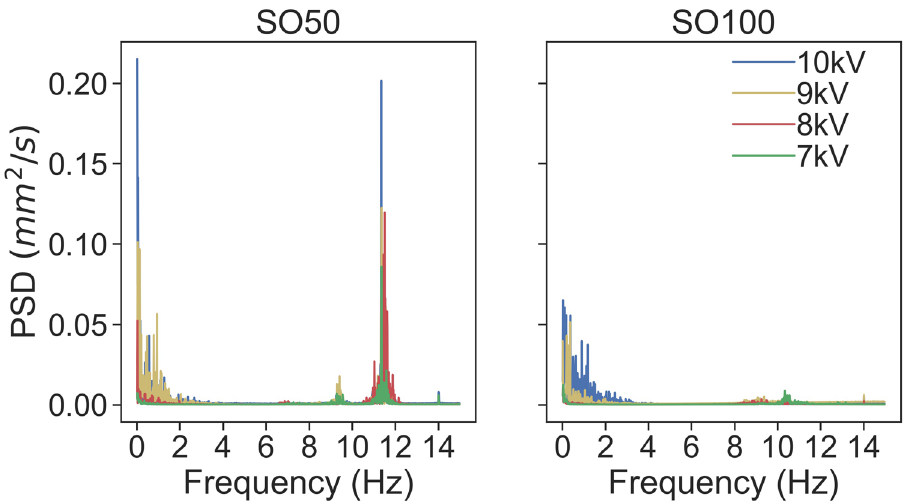
Fig. 3 The normalized power spectral density (PSD) plots of azimuthal velocity at four voltages for SO50 and SO100. Both subplots show high- magnitude frequencies below 2 Hz which contribute to the sloshing motion. The 11.3 Hz peak associated with the noise floor becomes more promi- nent for the lower viscosity oil